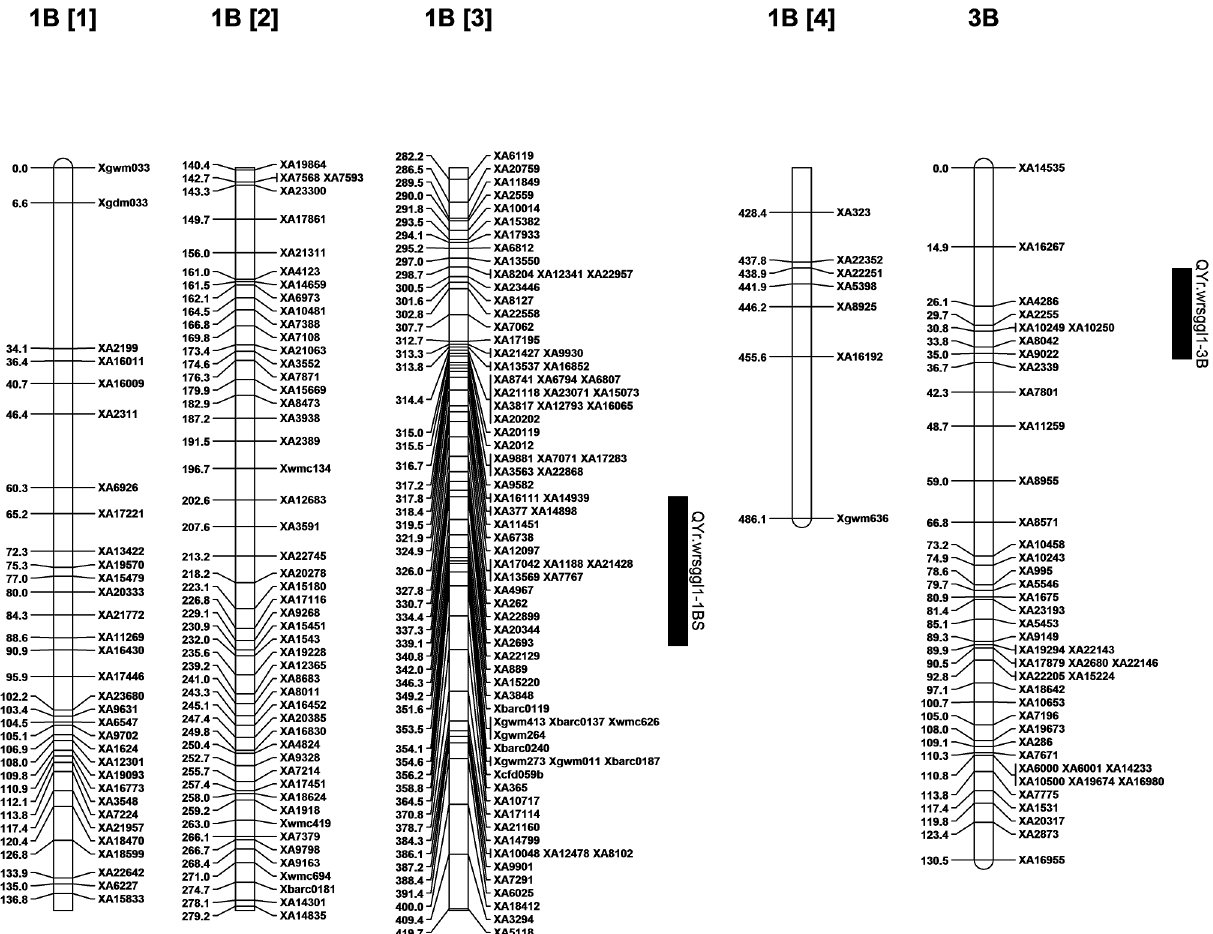
Fig 2. Chromosomal location of quantitative trait loci (QTLs) for stripe rust resistance in the AvS × PI